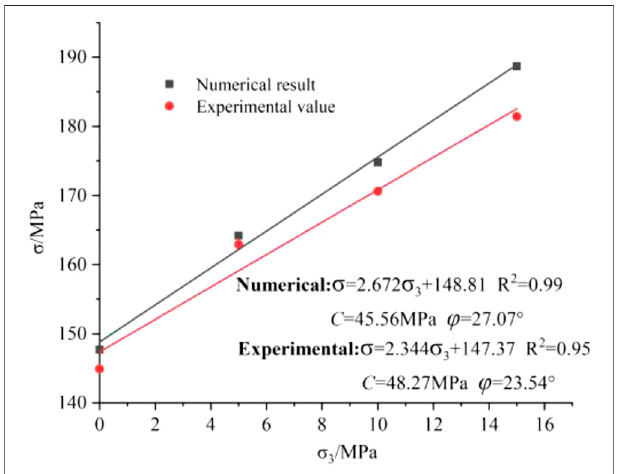
FIGURE 4 | Relationship between con fi ning pressure and peak strengths from laboratory tests and numerical simulation.